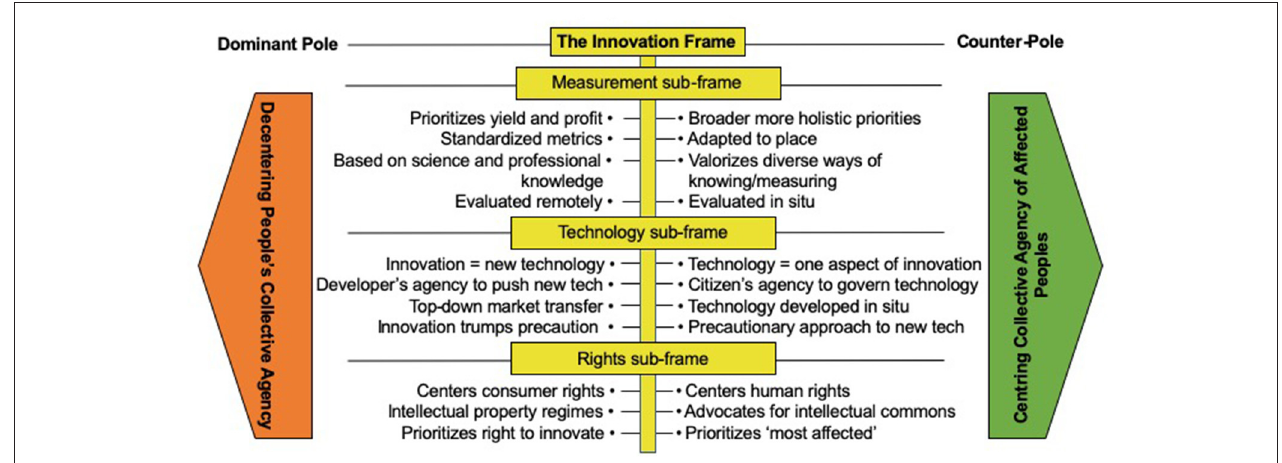
FIGURE 1 | The sub-frames of the innovation frame have both a “counter-pole” that centers the collective agency of people and a dominant pole that decenters people’s collective